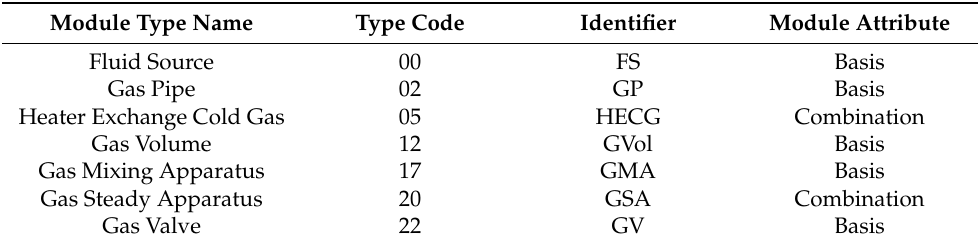
Table 1. Modularization disassembly of the core engine test rig main test